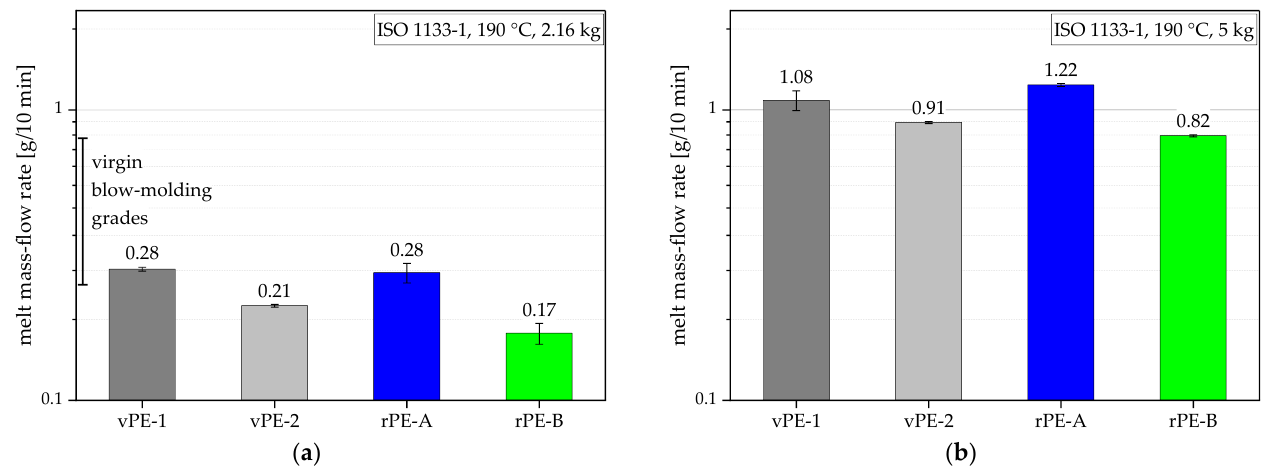
Figure 4. Graphical illustration and values of MFRs for all materials measured according to ISO 1133-1 at 190 °C and 2.16 kg ( a ) and 5 kg ( b ).